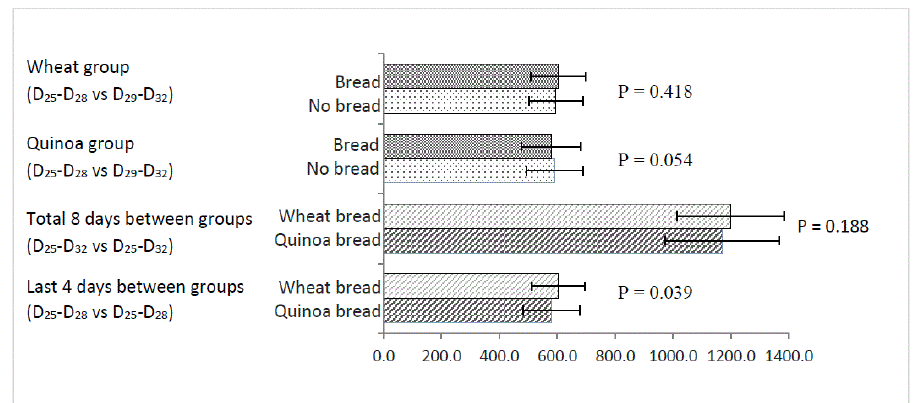
Figure 3. The area under curve of glucose concentration responses to intake of refined wheat and quinoa bread during 8 days (D 25 –D 32 ). Values are means with their standard deviations represented by horizontal bars ( n = 24). Bread means 4-day period whilst consuming the study breads at the end of the treatment period (D 25 –D 28 ); No Bread means the first 4 days of the washout period (D 29 –D 32 ). Difference was considered as significant if p < 0.05 (paired-samples t test).